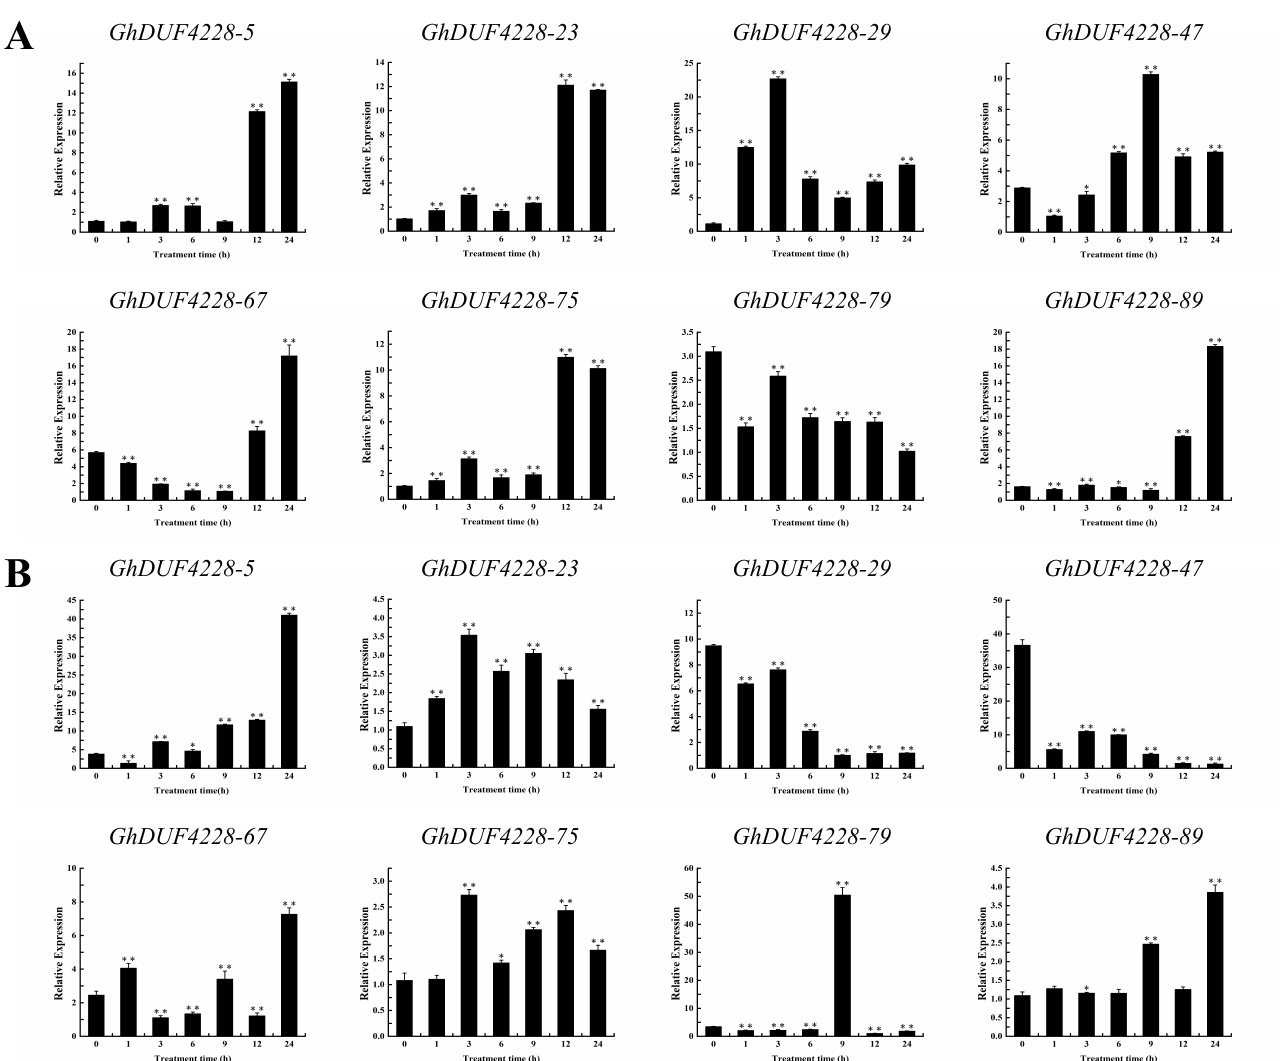
Figure 6. Expression patterns of GhDUF4228 genes under salt and drought stress. ( A ) Expression levels of GhDUF4228 genes at 0, 1, 3, 6, 9, 12, and 24 h under NaCl treatment, ( B ) expression levels of GhDUF4228 genes at 0, 1, 3, 6, 9, 12, and 24 h under PEG treatment. Error bars represent the standard deviation of three independent biological replicates. ( * p < 0.05, ** p < 0.01 Student’s t